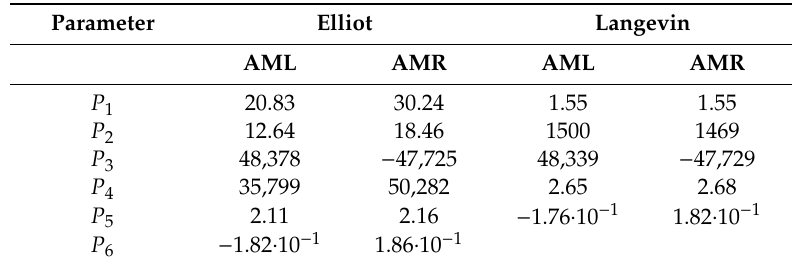
Table 18. Calculated parameters of the Alnico major hysteresis loop.